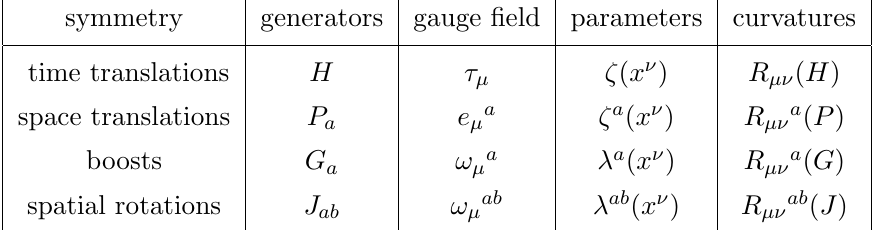
Table 2 . This table indicates the generators of the Carroll algebra and the gauge (cid:12)elds, local parameters and curvatures that are associated to each of these